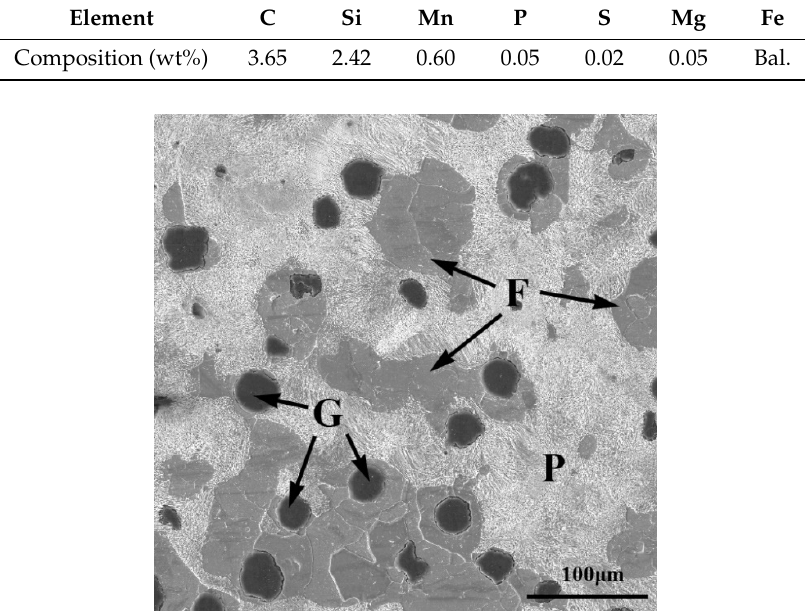
Figure 2. Microstructure of ductile iron.